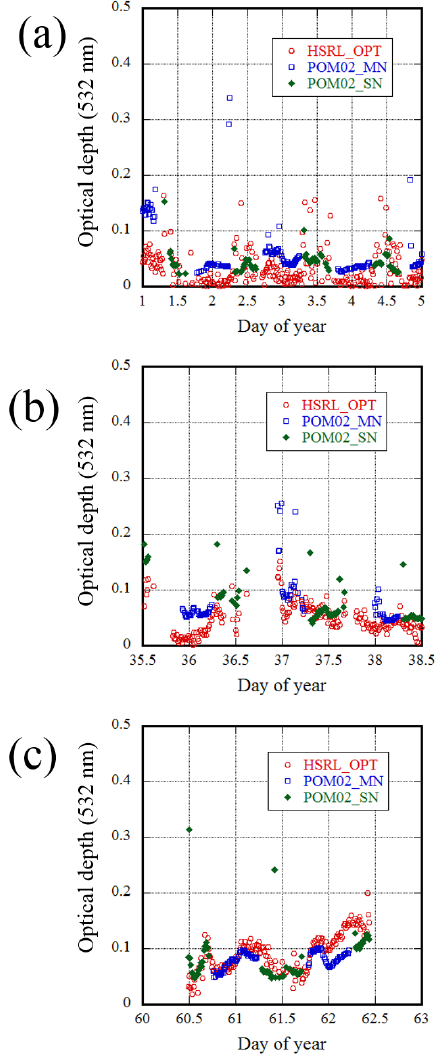
Figure 8. Examples of time series of HSRL (red), POM-02 day- time (green), and nighttime (blue) aerosol optical depths at 532nm. The phase angles ( g ) during the measurement periods were (a) g = − 21 . 863 to 35.881 ◦ , (b) g = 47 . 454 to 83.190 ◦ , and (c) g = − 19 . 150 to 21.573 ◦